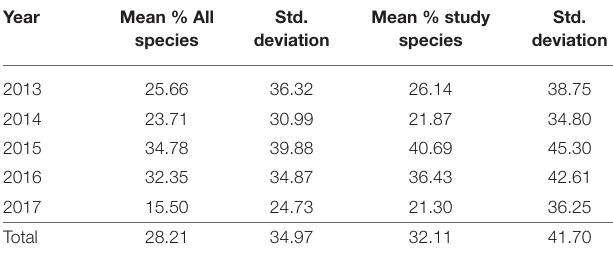
TABLE 5 | Mortality rates for day shore competitions from January to June 2017.